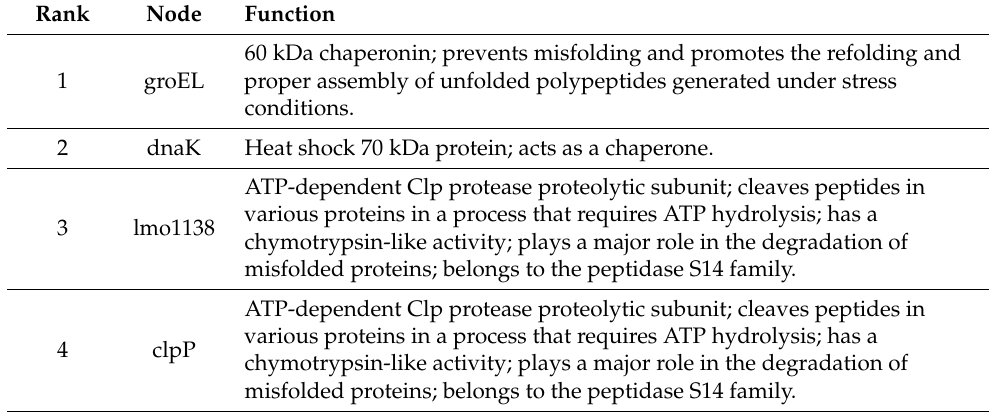
Table A1. Summary of top 7 nodes for stress